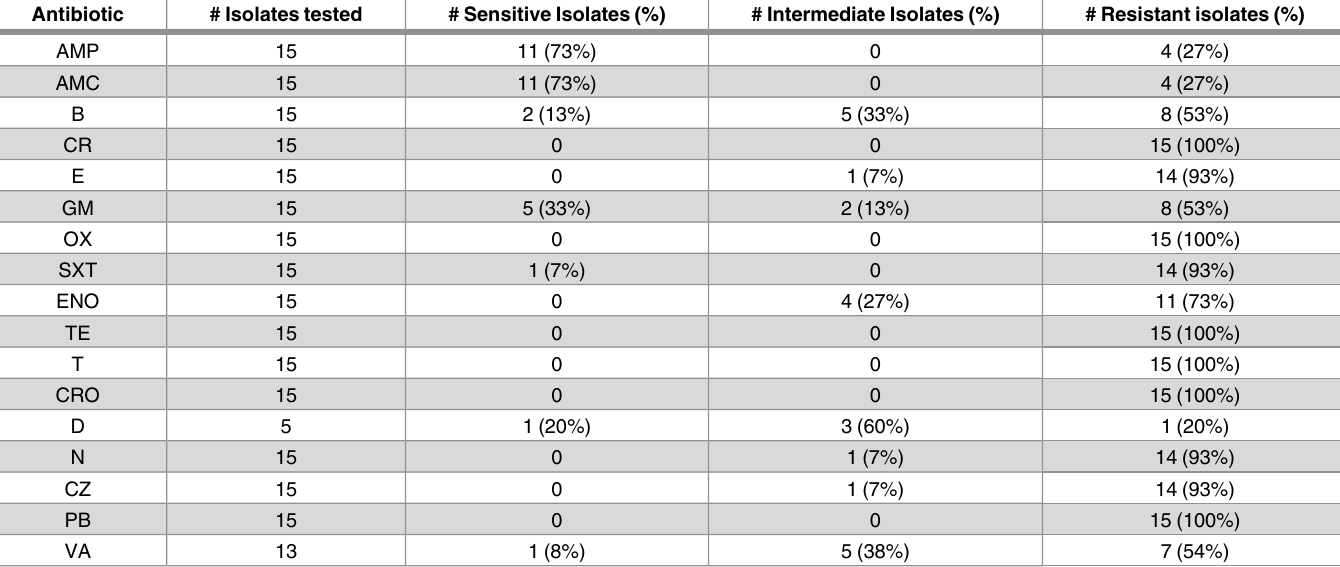
Table 5. Kirby Bauer Disk Diffusion Results for 15 Macaque Chamber E . faecalis Isolates.